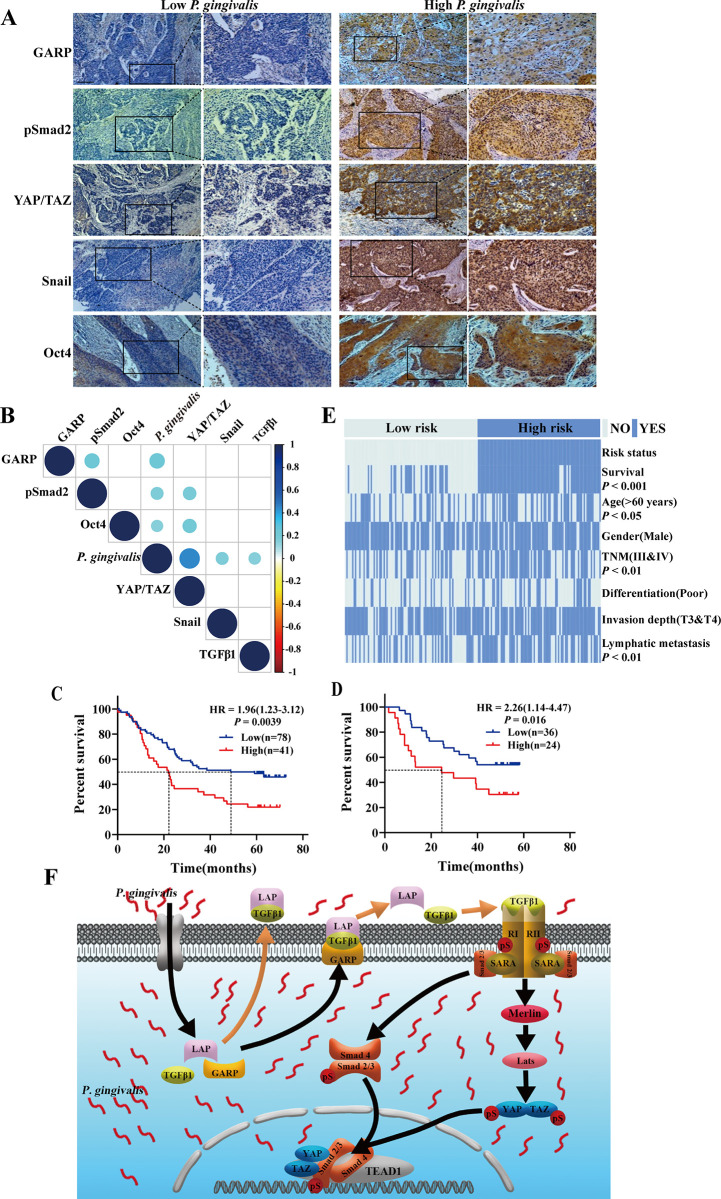
P. gingivalis-activated effectors correlate and are relevant in ESCC patients.(A) Representative IHC of GARP, pSmad2, YAP/TAZ, Snail, and Oct4 proteins in ESCC tissues from patients with low and high levels of P. gingivalis in ESCC. Scale bars represent 200 μm and 100 μm, respectively. (B) Correlations among P. gingivalis, GARP, TGFβ, pSmad2, YAP/TAZ, Snail, and Oct4 levels in 190 ESCCs. (C & D) The P. gingivalis signature gene sets predict overall survival of patients with ESCC. Kaplan–Meier survival curves of patients in the training set (C) and test set (D) were classified into low- and high-risk groups. (E) Comparison of clinicopathological features between the low- and high-risk groups classified by P. gingivalis signature-gene–based classifier. Statistical significance was performed by chi-square test. (F) A proposed model for P. gingivalis-induced aggressive progression of ESCC. ESCC, esophageal squamous cell carcinoma; GARP, glycoprotein A repetitions predominant; IHC, immunohistochemistry; LAP, latency-associated protein; Lats, large tumor suppressor homolog; Merlin, moesin-ezrin-radixin-like protein; pS, phosphorylated serine/threonine; pSmad, phosphorylated Smad; SARA, Smad anchor receptor activation; Smad, Drosophila mothers against decapentaplegic homolog; TAZ, Transcriptional coactivator with PDZ-binding motif; TEAD1, TEA domain transcription factor1; TGFβ, transforming growth factor-β; TNM, tumor-node metastasis; YAP, Yes-associated protein.